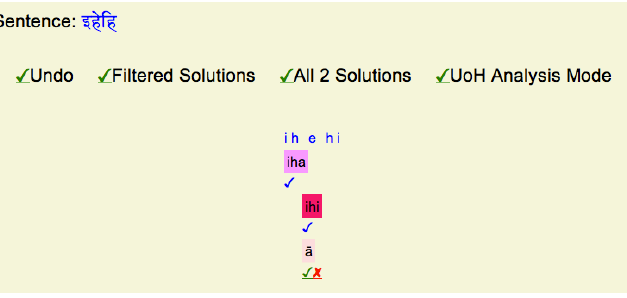
The aligned segmentations for ihehi